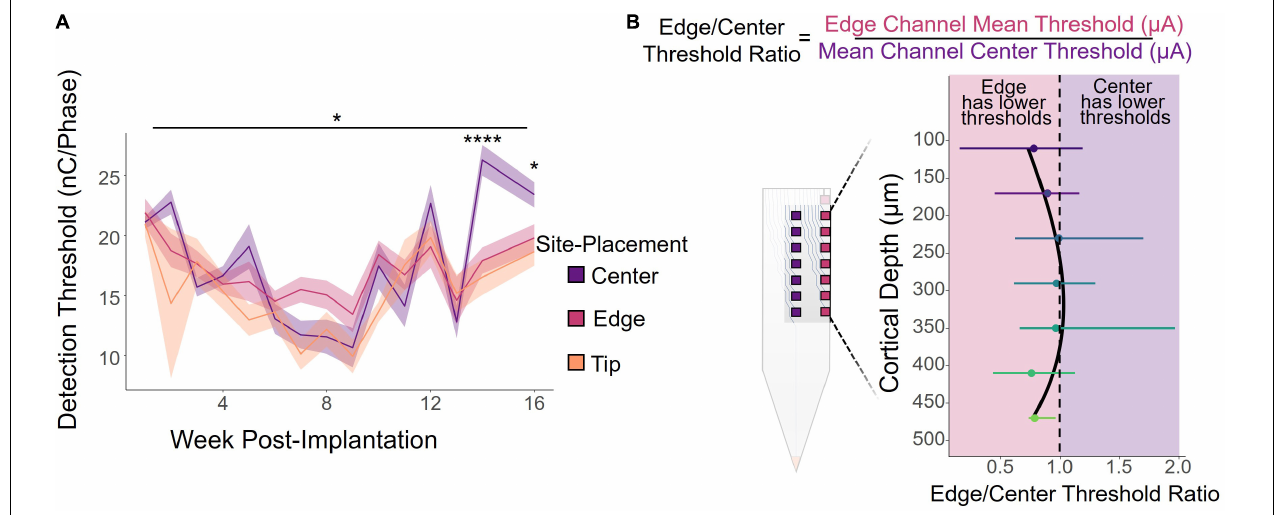
FIGURE 2 | ICMS detection thresholds by electrode-site placement. (A) Average detection thresholds for center, edge, and tip sites over a 16-week period for all six animals. Shading indicates standard error. * p ≤ 0.05, **** p ≤ 0.0001 (B) Edge/Center threshold charge ratio by cortical depth, calculated by dividing the average threshold of an edge channel by the threshold of the corresponding center channel at the same cortical depth, weekly per animal. Channels toward the middle of the array (cortical depths of 240–360 µ m) had ratios near 1, indicating that there was little or no difference in the charge required to elicit a response between the center and edge sites. However, the deeper and superficial channels had ratios less than 1, indicating that edge sites had lower thresholds on average. Error bars indicate standard deviation.